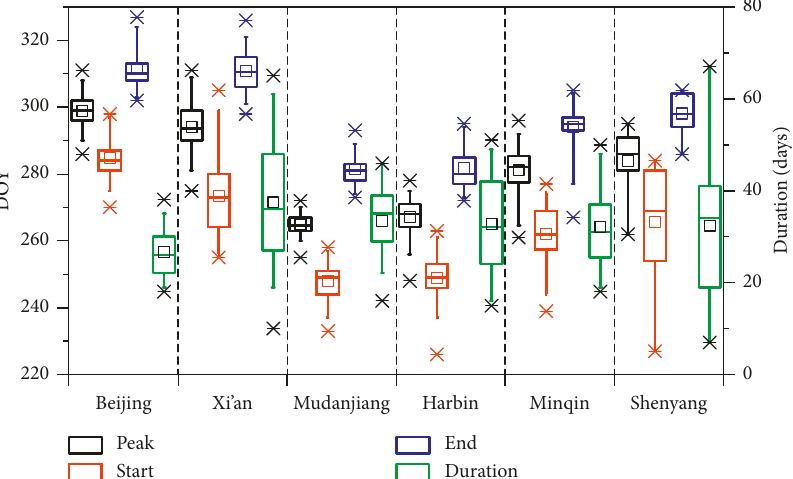
Figure 4: Boxplot of the peak, start, end, and duration of the leaf coloring season at six sites. The bottom and top of the boxes and the end of the whiskers are the 25 th , 75 th , and 95 th percentiles, respectively. The bands and squares in the boxes show the median and mean value.